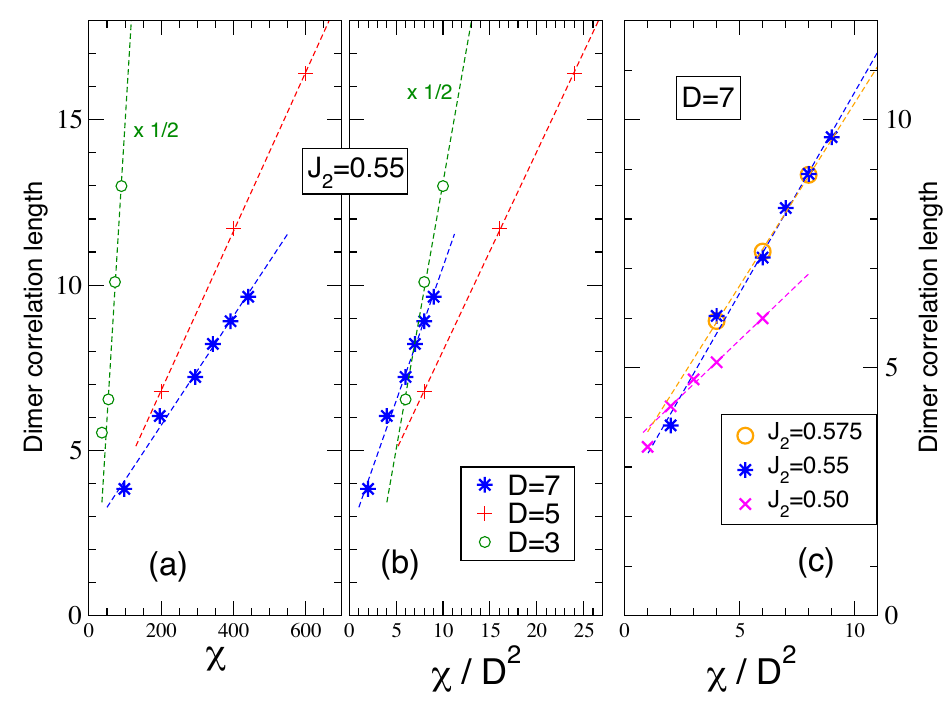
= 0.55 plotted vs environment dimension at J d 2 vs χ/ D 2 for different J d